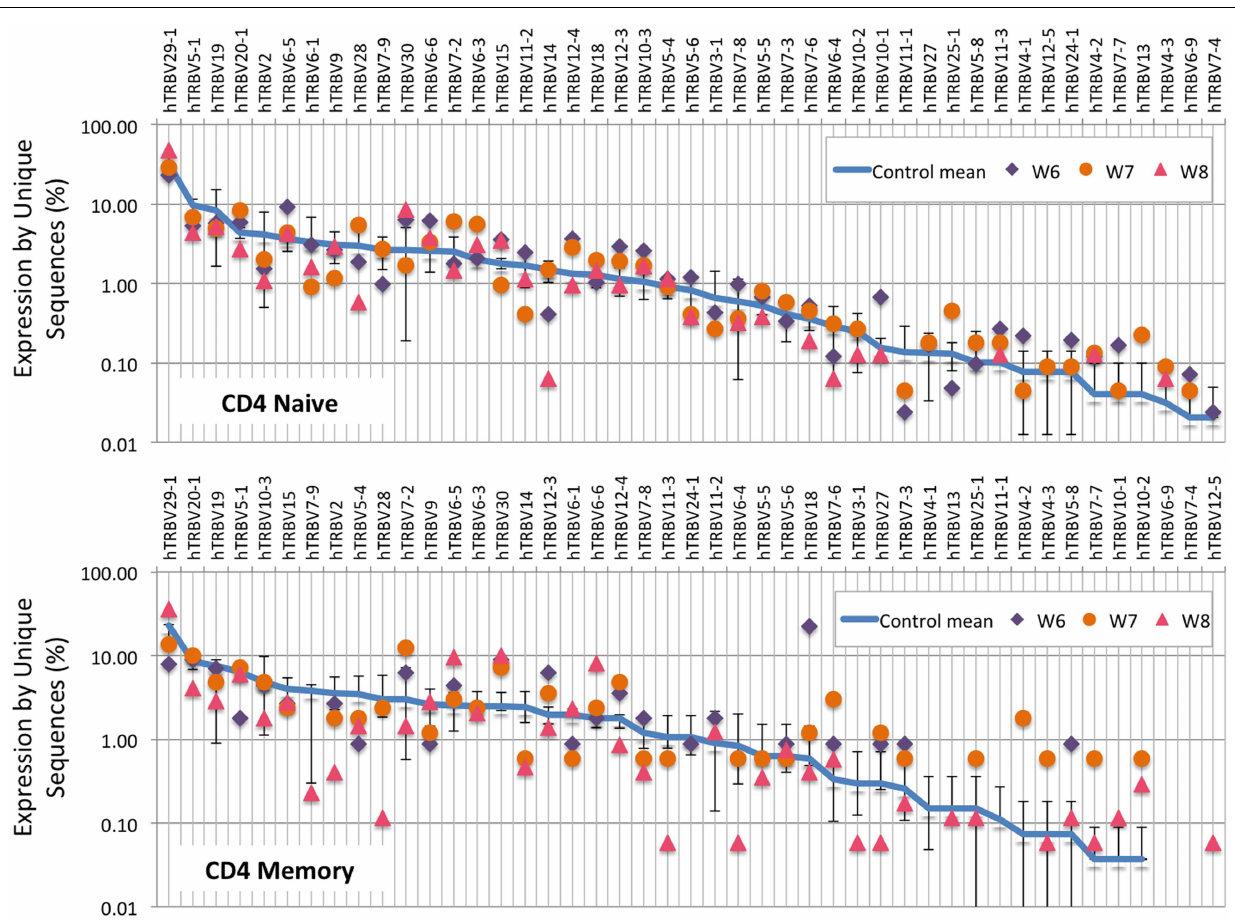
FIGURE 7 | TRBV gene usage in CD4 + naive and memory lymphocytes from healthy controls and patients withWAS .The frequency of usage of individual TRBV genes in unique TRB sequences is displayed for CD4 + naïve